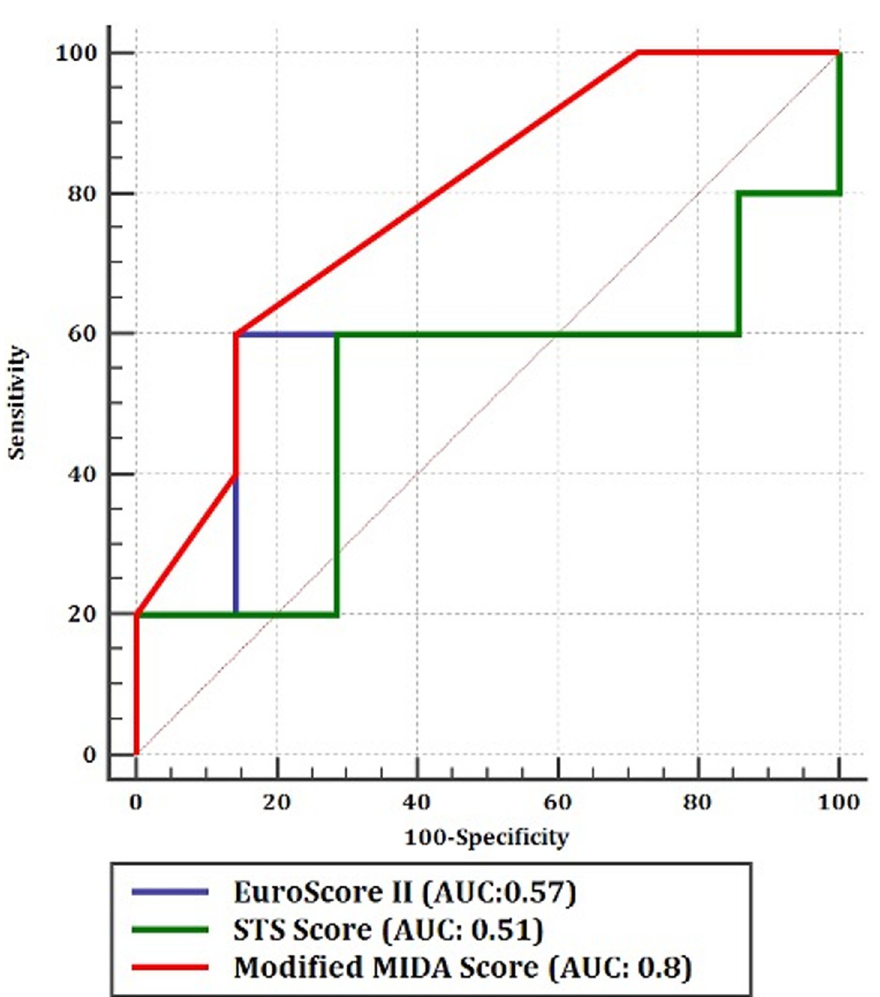
Fig 6. Comparison of score systems in FMR patients: Comparison of ROC curves. (AUC: Area under the curve, STS: The Society of Thoracic Surgeons, MIDA: The Mitral Regurgitation International Database).